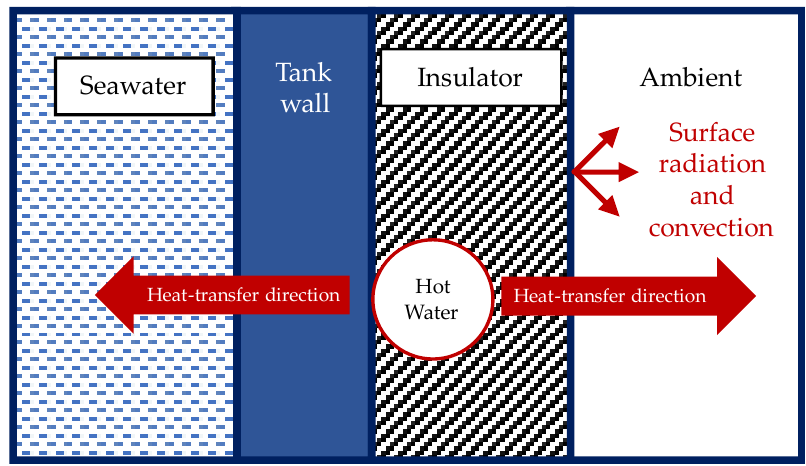
Figure 9. Directions of heat transfer between the coil heater, the fluid in the tanks, and the ambient air. Figure 10 illustrates the heat-transfer direction from the water inside the coil heater to the fluid inside the tank. The overall heat-transfer coefficient for the heat transfer from the coil heater to the fluid inside the tank is shown in Equation (11). Furthermore, the pre-calculation indicated that the flow inside the tank was laminar. In terms of geometry, the cylinder tank wall in this system model could be treated as a flat plate for the thermal resistance circuit analysis since the condition for the present case study was satisfied according to Equation (12) [35]. Because of this condition, the Nusselt number correlation expressed in Equation (7) could also be used for the inner side of the tank in the current system model. Equation (13) is the Nusselt number correlation used to determine the convective heat-transfer coefficient in the coil heater [37]. The thermal conduction resistance analysis along the walls of the feed-mixing tank and bioreactor tank covered by the insulator and the heater coil was expressed by Equations (16) and (18)